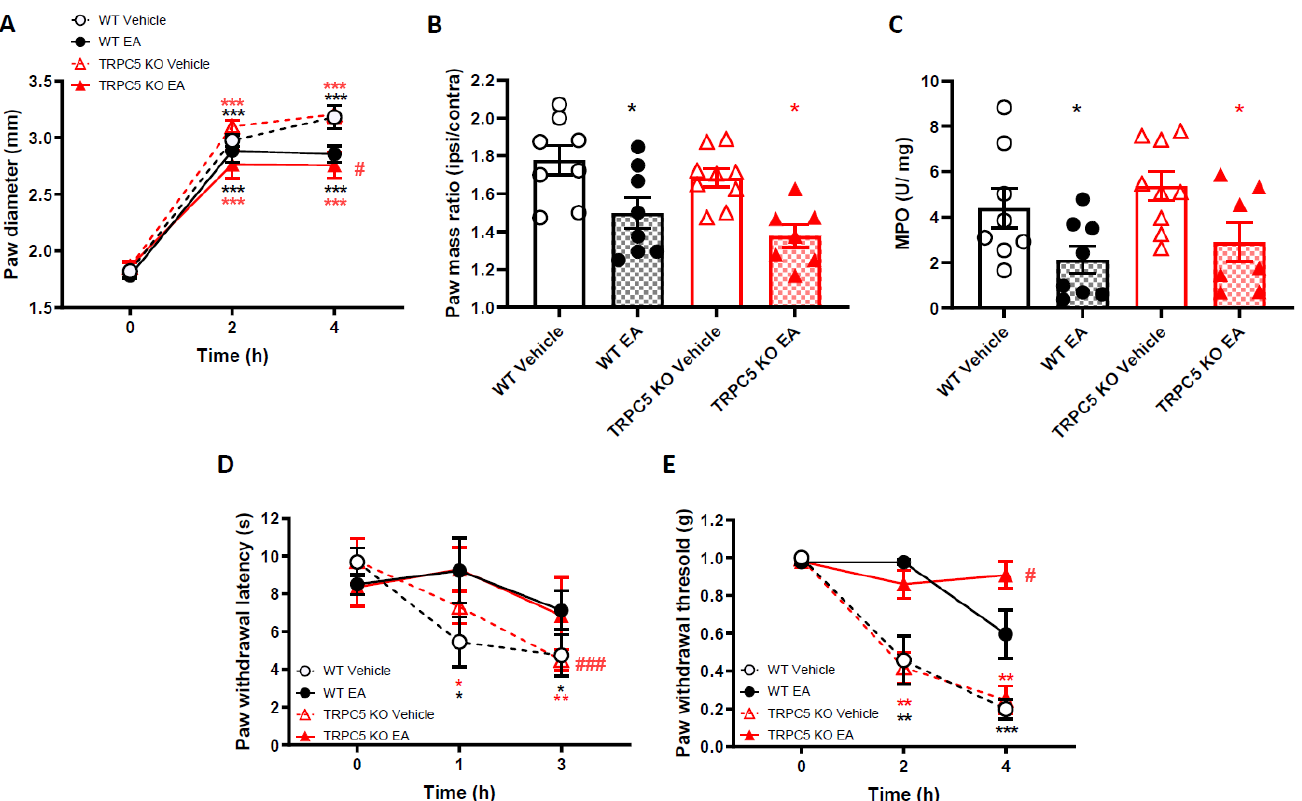
Figure 3. Englerin-A reduces carrageenan-induced paw oedema and mechanical and thermal hyperalgesia, in both WT and TRPC5 KO mice. ( A ) Time-course of paw oedema measured by callipers and ( B ) ipsilateral/contralateral paw mass ratio 4 h following induction of paw oedema by 2% Carrageenan. Data are mean ± S.E.M, n = 8. * p < 0.05, *** p < 0.001 versus baseline, # p < 0.05, versus vehicle, Two-way ANOVA, post hoc Tukey test. ( C ) Myeloperoxidase (MPO) levels in paw exudates, 4 h after the induction of paw inflammation. Data are mean ± S.E.M, n = 8. * p < 0.05 versus vehicle, unpaired t-test. ( D ) Thermal and ( E ) mechanical paw withdrawal thresholds measured at baseline and at 1 and 3 or 2 and 4 h, respectively, after intra-plantar injections of carrageenan. * p < 0.05, ** p < 0.01, *** p < 0.001 versus baseline, # p < 0.05, ### p < 0.001 versus vehicle, Two-way RM ANOVA, post hoc Tukey test. Data are mean ± S.E.M, n = 8.